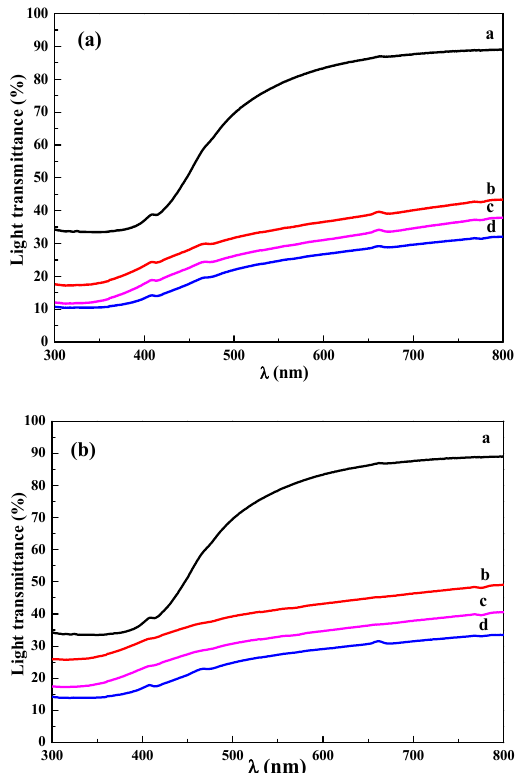
Figure 8. The UV-vis transmission spectra of CS/MAG ( a ) and CS/KH550/MAG ( b ) hybrid membranes with different quality proportion, a for pure CS membrane, and b, c, and d for CS: MAG = 9:1; 7:3; 5:5, respectively.